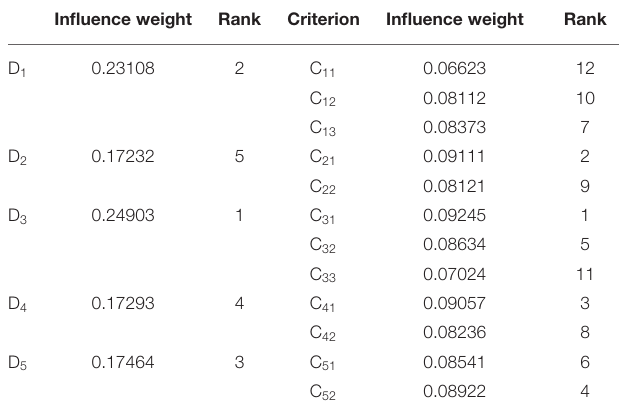
TABLE 5 | Normalized rank of mixed weights of clusters and factors influencing enterprise food fraud.